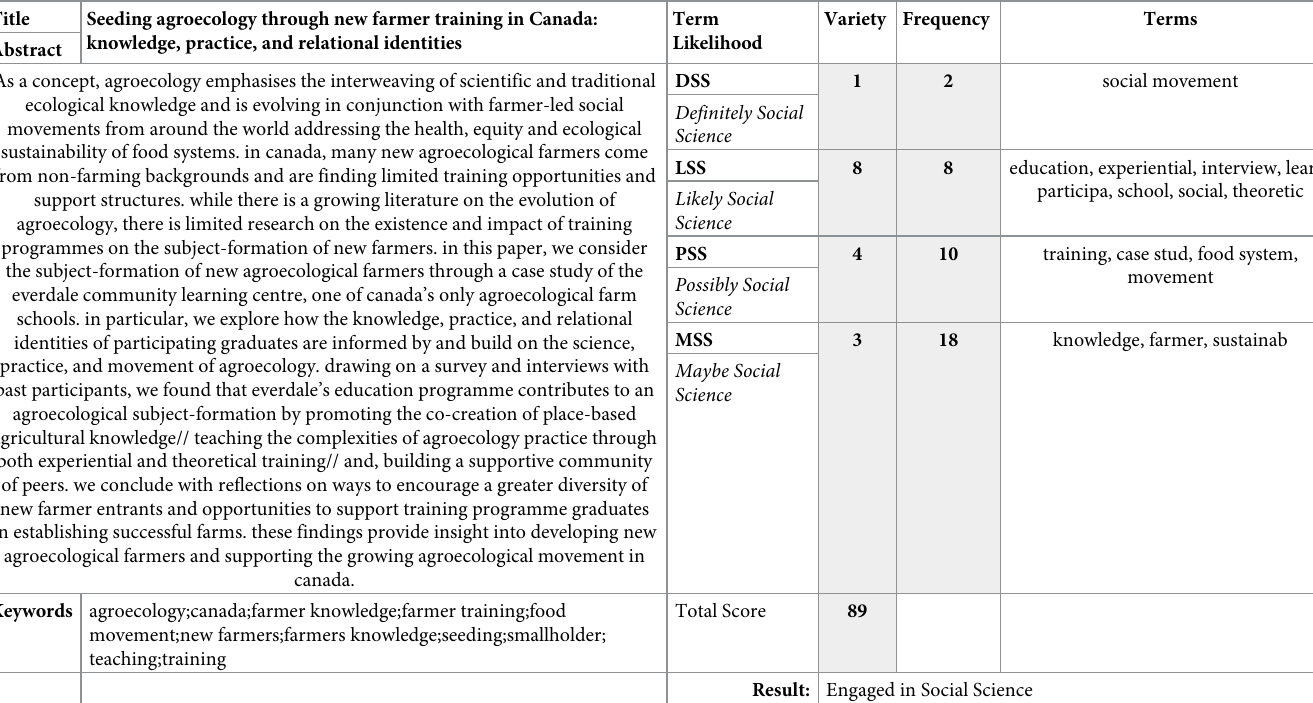
Table 1. An example of a publication differentiation script